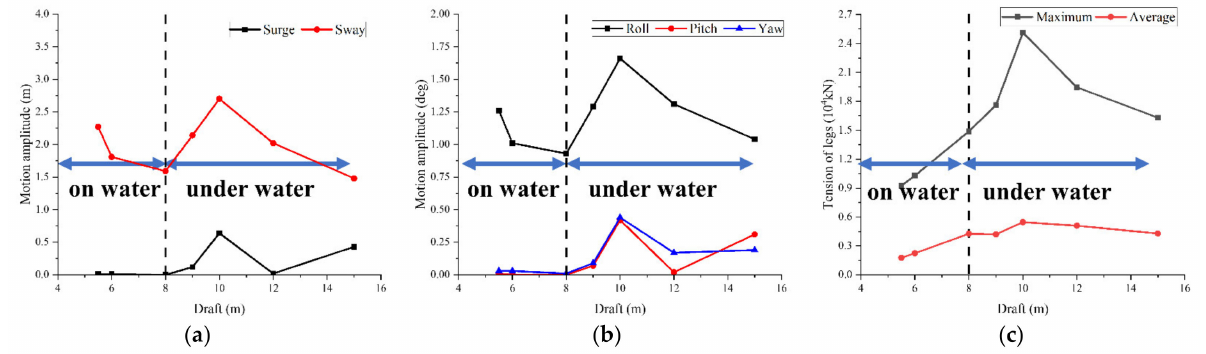
Figure 7. Effect of draft on motion amplitude and tension on four tension legs: ( a ) surge and sway, ( b ) draft on roll, pitch, and yaw, and ( c ) maximum and average tension of tension leg.